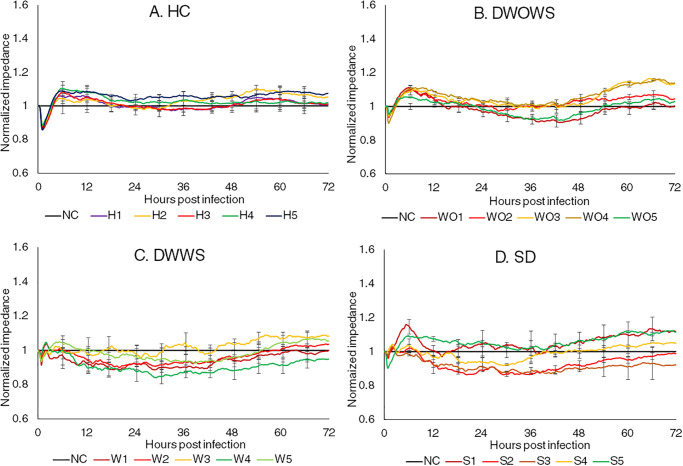
Normalized real time impedance changes in dermal MECs incubated with serum samples from the category of (A) Healthy individuals (HC), (B) dengue without warning signs (DWOWS), (C) dengue with warning signs (DWWS) and (D) severe dengue (SD). Five serum samples from each dengue category consisted of samples with high NS1 level (red lines), medium NS1 level (yellow lines) and low NS1 level (green lines). The error bars represent the standard error of mean between three biological triplicates for each sample.